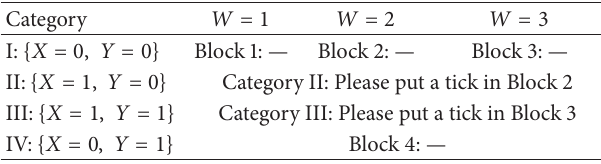
Table 1: The main questionnaire for the combination questionnaire model.